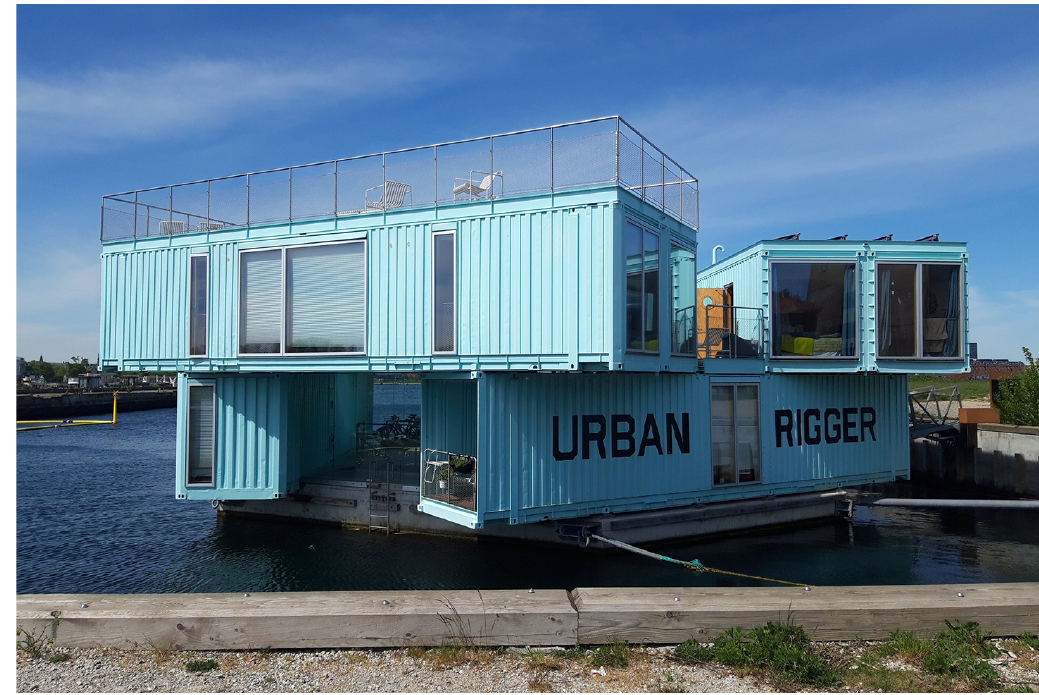
Figure 7. The Urban Rigger , Copenhagen, 2016, by BIG. Source: author. bine modular construction with self-building (Duncan &